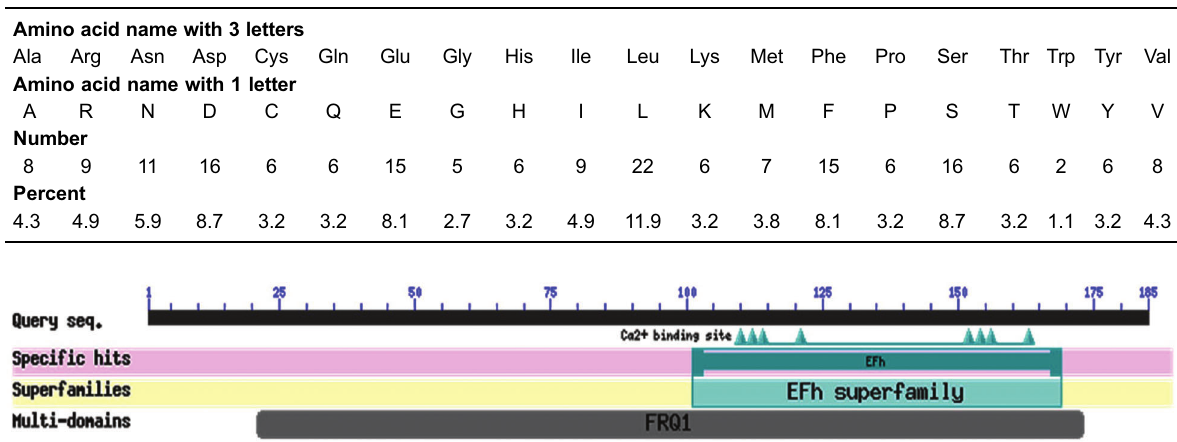
Table 1. Amino acid composition of CIB 4 gene in Kermani sheep.